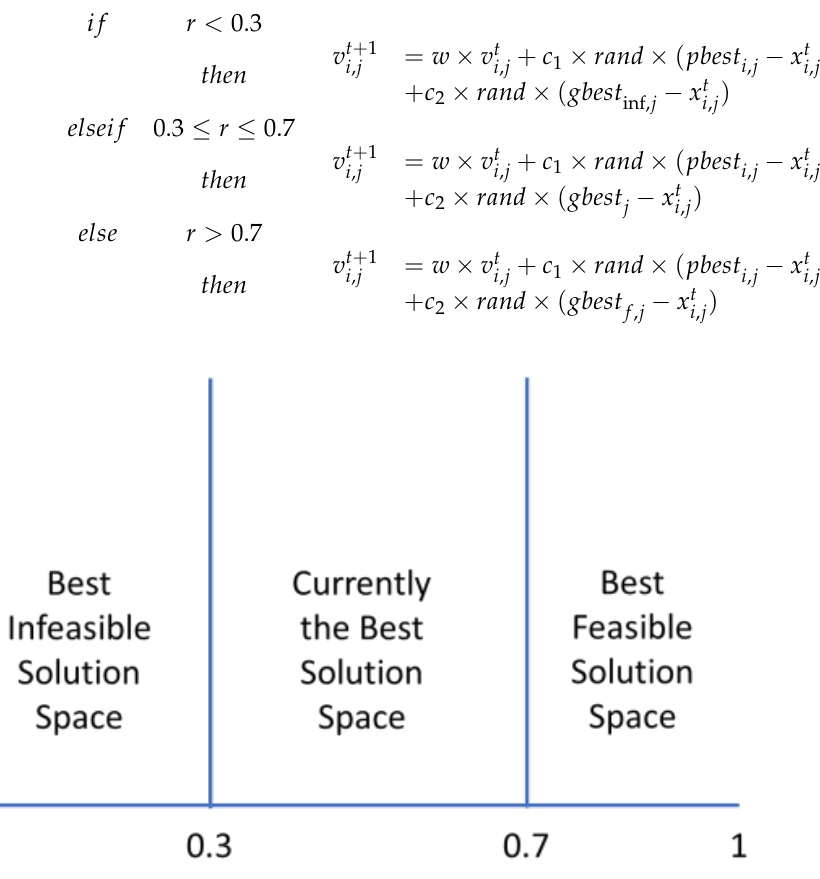
Figure 1. The auto-tuning scheme of FPSO.